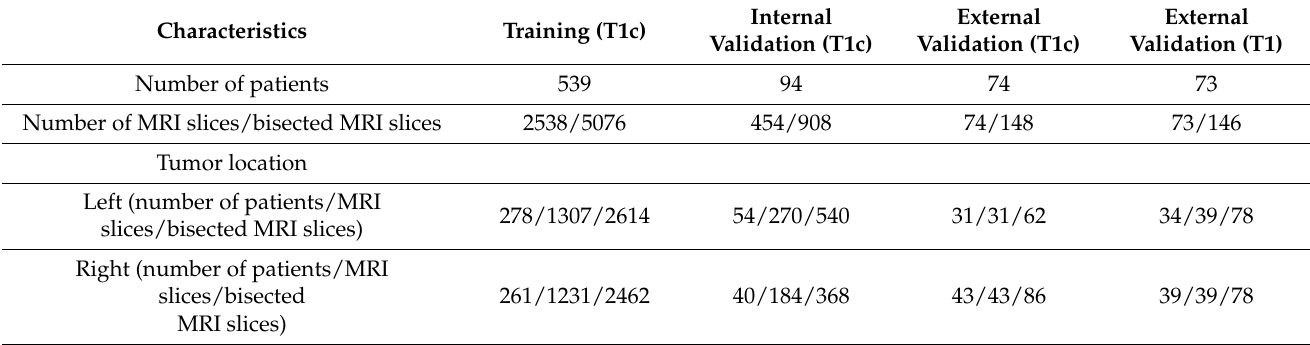
Table 1. Characteristics of the included patients and the corresponding magnetic resonance